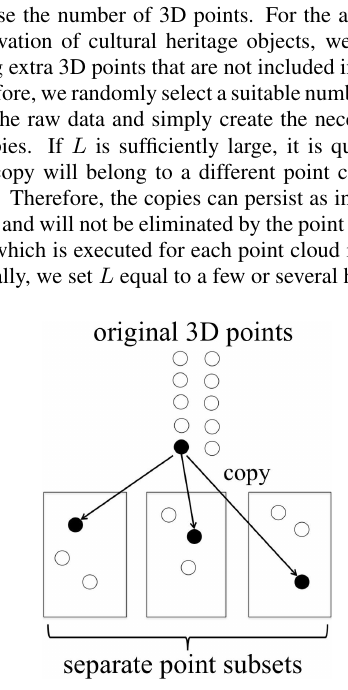
Figure 4. Schematic illustration of the point proliferation by copying the original laser-scanned 3D points. Each copied 3D point belongs to a separate point subset with a high probability when L is sufficiently